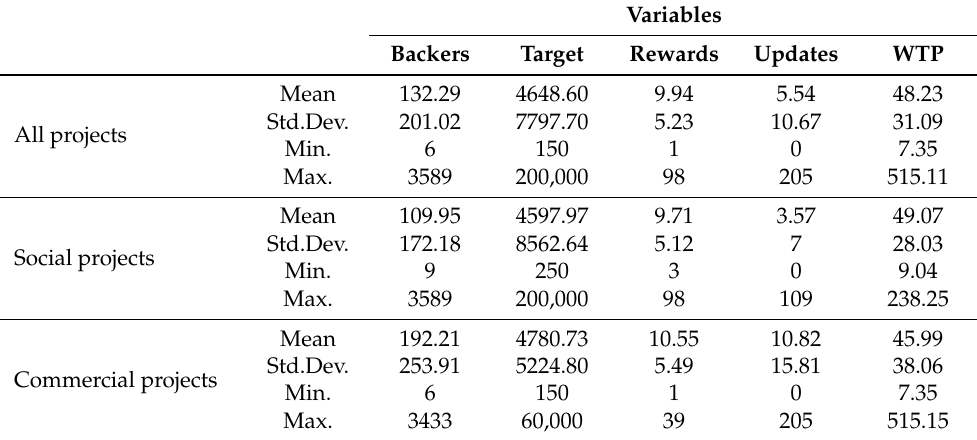
Table 1. Summary statistics.